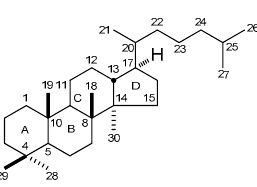
Figure 1. The basic skeleton of dammarane-type triterpenoids.